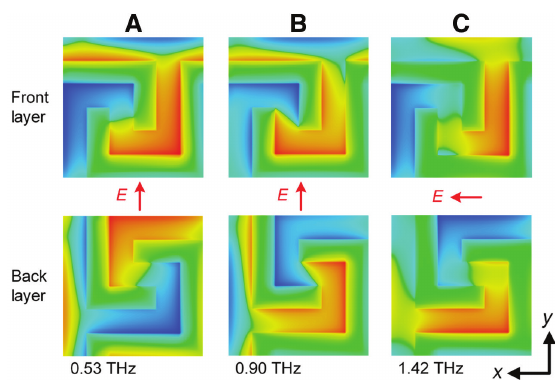
Figure 5: Z-component magnetic field distributions at three resonant asymmetric transmission (AT) peaks. The resonant frequencies are (A) 0.53 THz, (B) 0.90 THz and (C) 1.42